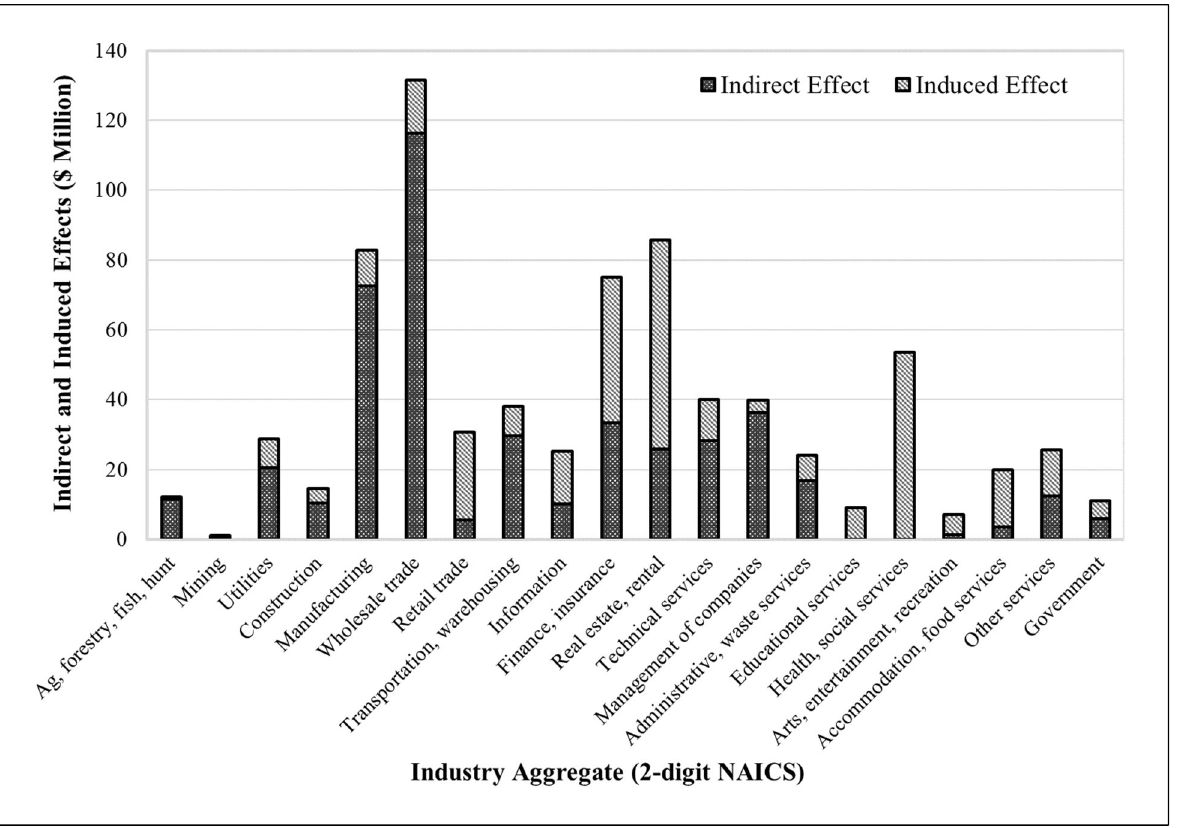
Figure 1. Indirect and Induced Output Effects by Industry for New York State Apple Industry from the US$1,309.9 Million Direct